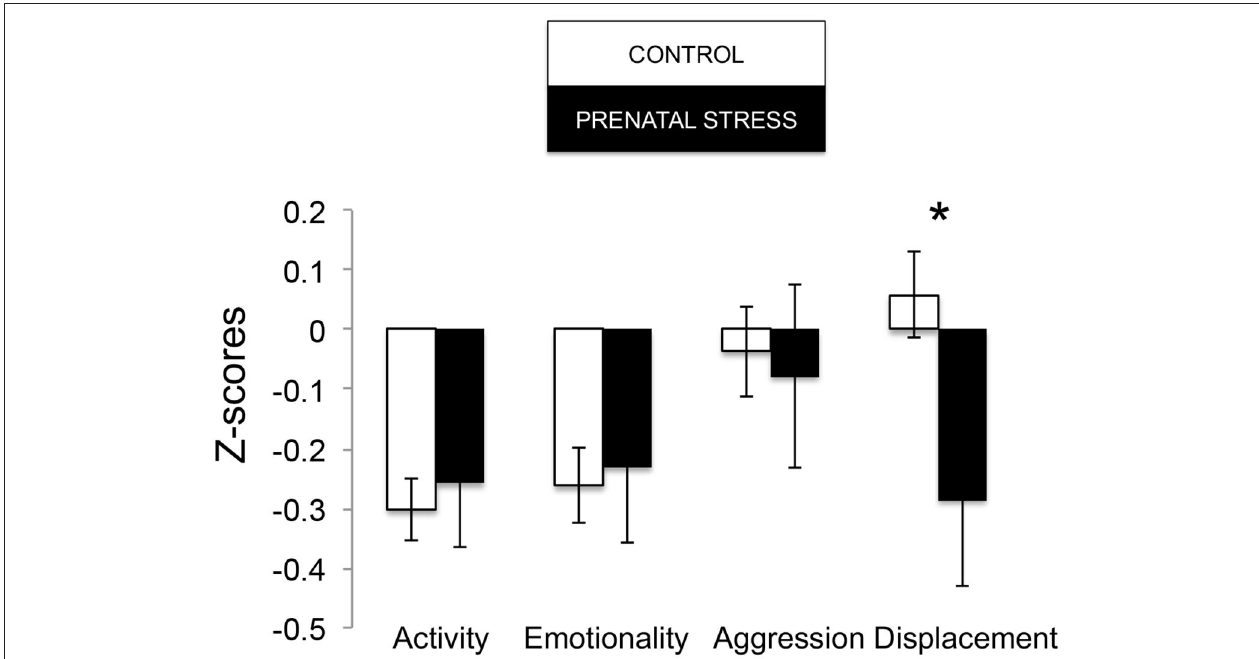
FIGURE 2 | Human Intruder response during biobehavioral assessment between offspring of prenatally stressed mothers ( n = 39) and control mothers ( n = 149). Means are presented ± standard error of the mean. * p < 0.05.